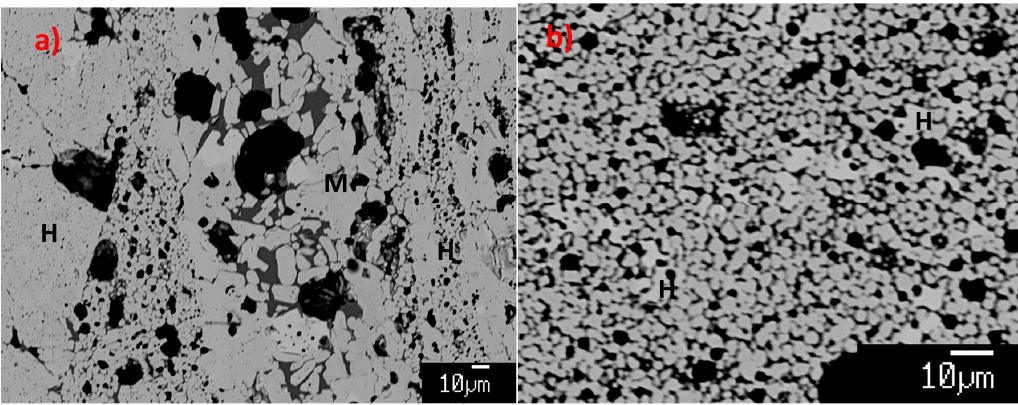
Figure 10. Examples of iron oxide structures in industrial sinter lumps, ( a ) a mixed hematite-magnetite